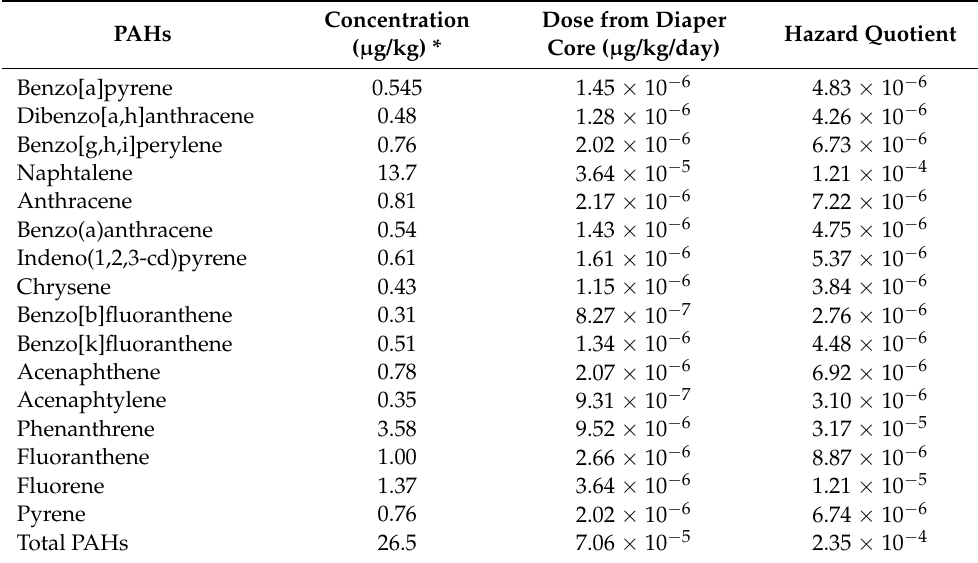
Table 2. Assessment of neurobehavioral risks of polycyclic aromatic hydrocarbons (PAHs) in the diaper